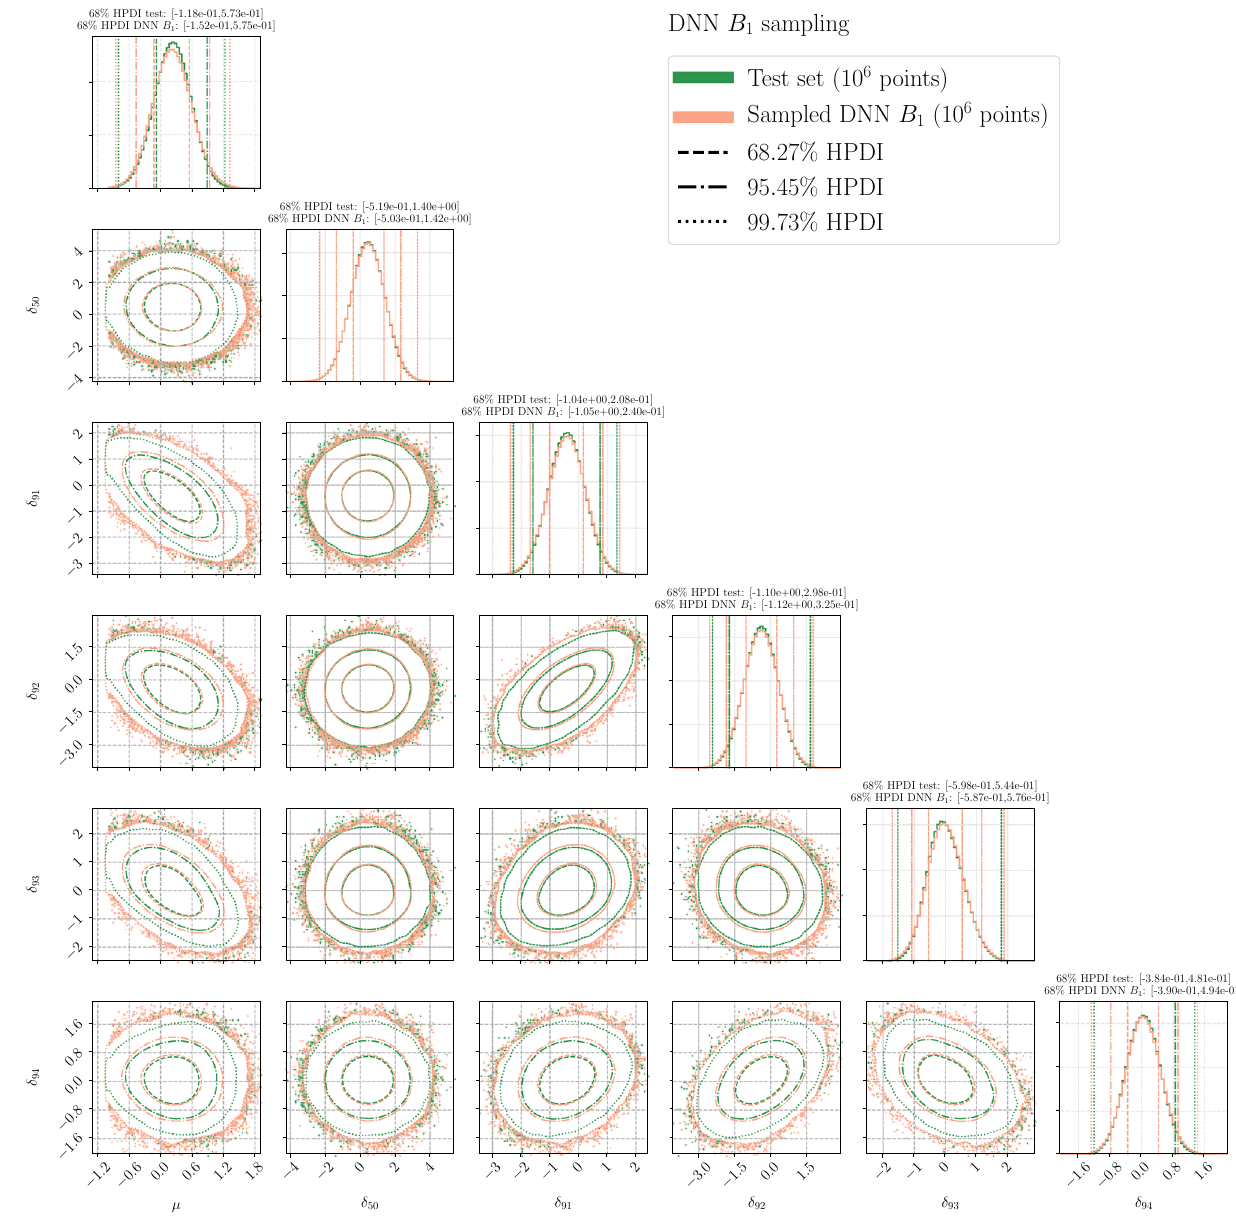
Fig. 9 1D and 2D posterior marginal probability distributions for a subset of parameters from the unbiased S 1 . The green (darker) distri- butions represent the test set of S 1 , while the red (lighter) distributions are obtained by sampling the DNNLikelihood B 1 . Histograms are made with50binsandnormalisedtounitintegral.Thedotted,dot-dashed,and